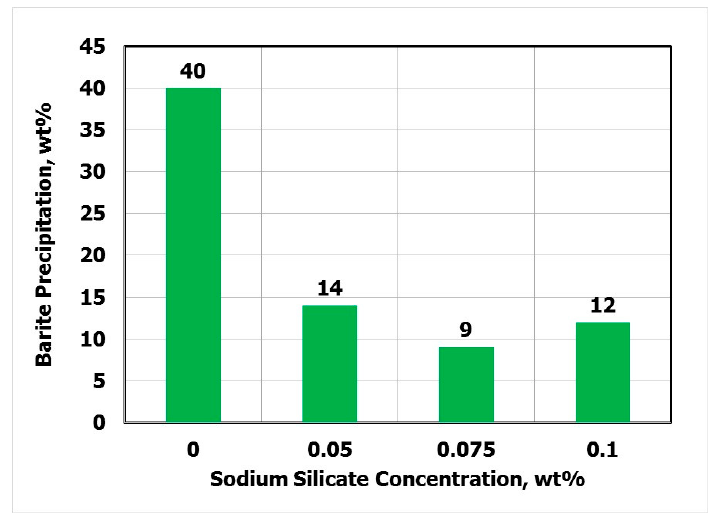
Figure 11. Effect of sodium silicate concentration on barite precipitation. Figure 11. E ff ect of sodium silicate concentration on barite